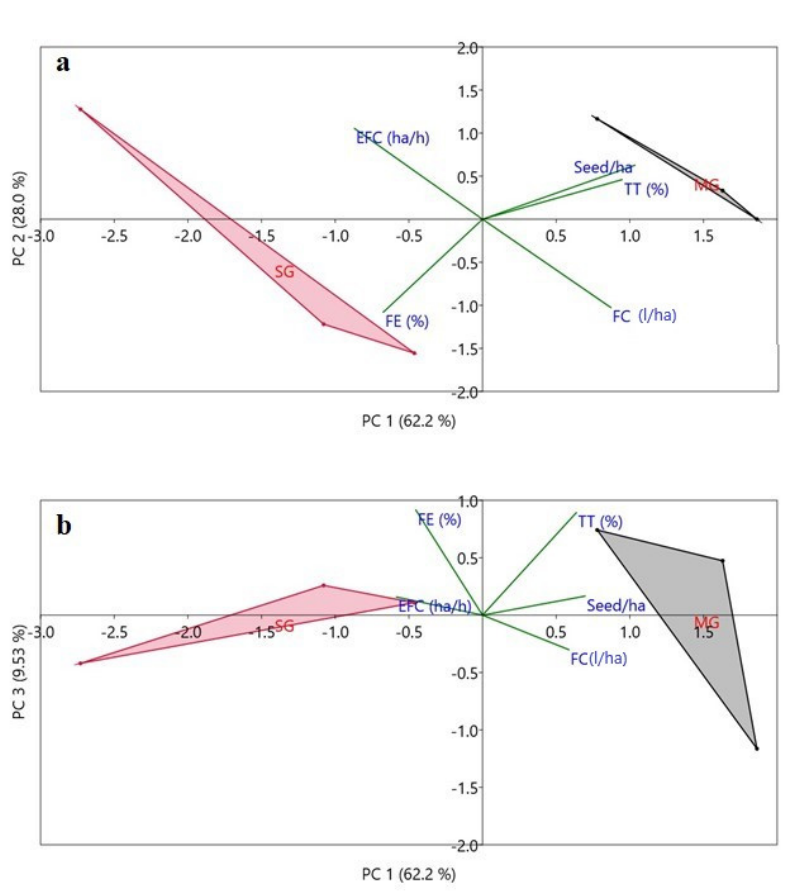
Figure 5. Principal Component Analysis performed considering seeds used per unit of surface (seed/ha), field efficiency (FE), effective field capacity (EFC), effective field speed (EFS), turning times (TT) and fuel consumption (FC). The plots represent the combination of PC1 with PC2 ( a ) and PC3 ( b ). MG are displayed,